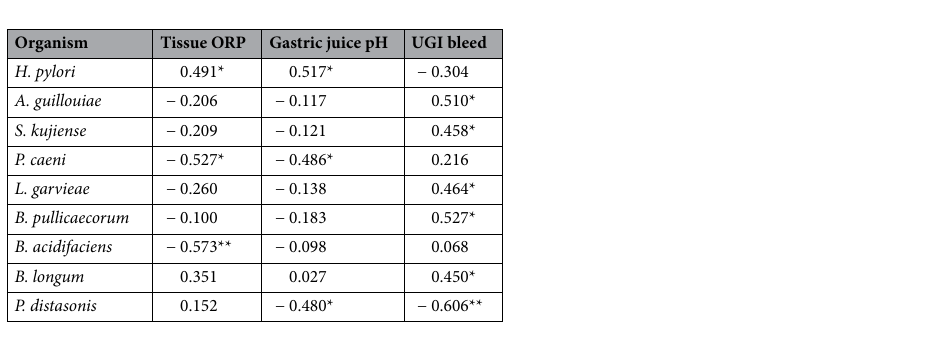
Table 3. Bivariate Pearson correlation analysis of species with respect to ORP, pH, and GI bleed. Significant values are in bold. *p value < 0.01 **p value < 0.001.